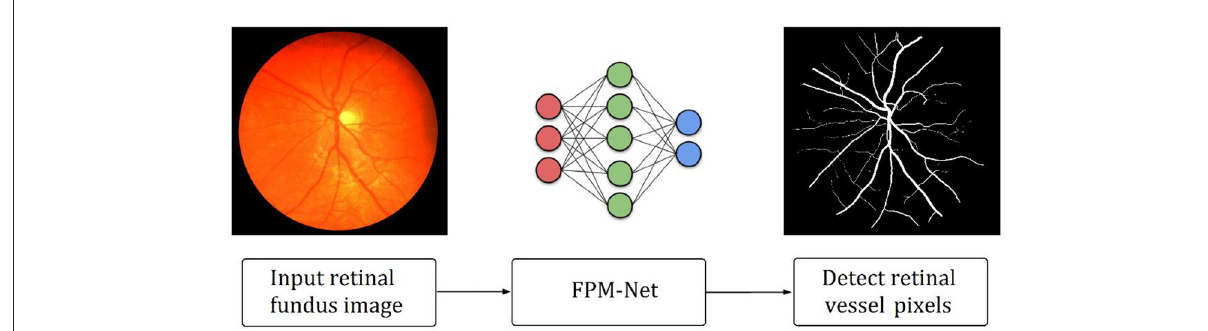
FIGURE1 Outline of the suggested FPM-Net approach.